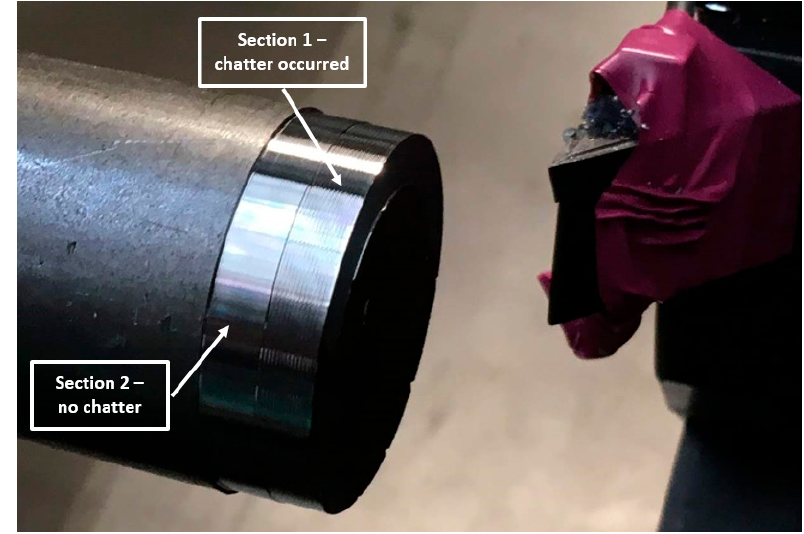
Figure 9. Experimental test “1” results—machined surfaces.